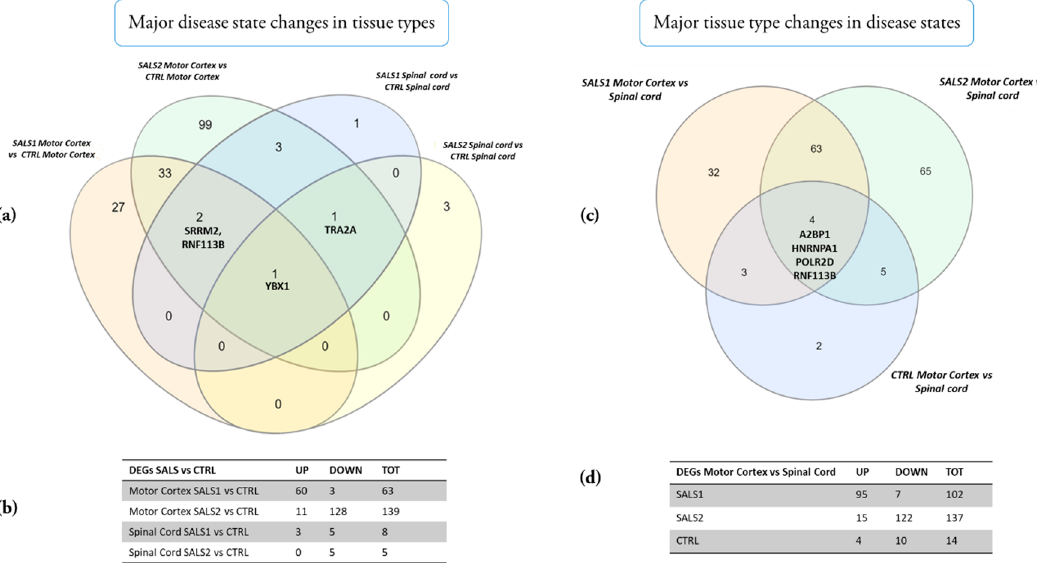
Figure 4. Venn diagrams of the total number of deregulated genes in SALS subtypes versus controls ( a ) and in motor cortex versus spinal cord ( c ). Tables show the numbers of up and down-regulated genes in SALS subtypes versus controls ( b ) and in motor cortex versus spinal cord ( d ), respectively.